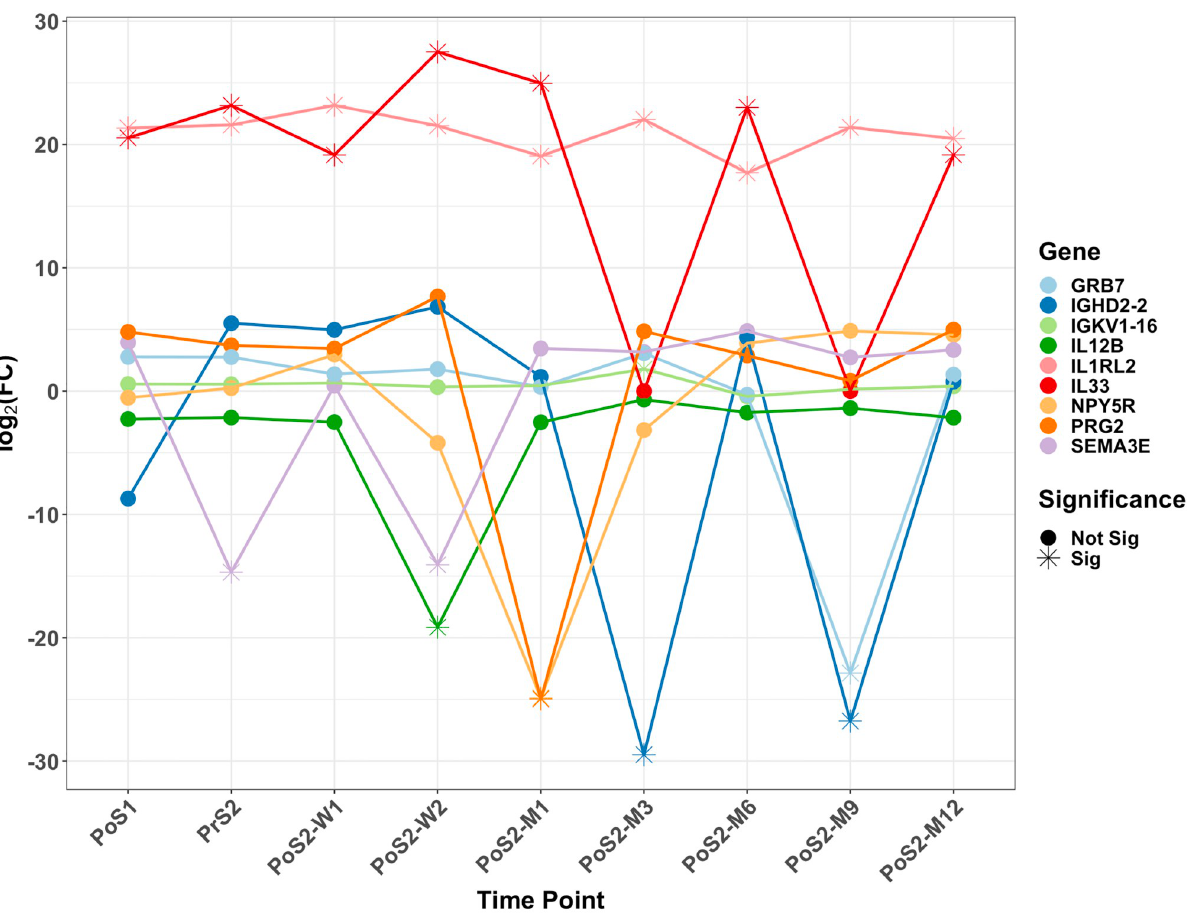
Fig 3. A scattergram showing the significantly differentially expressed genes annotated to inflammatory-related GO processes. Each time point was compared to the PrS1—which is considered as the baseline—read counts. Please note that two key genes, IL1RL2 and IL33, were consistently up- regulated with about 20